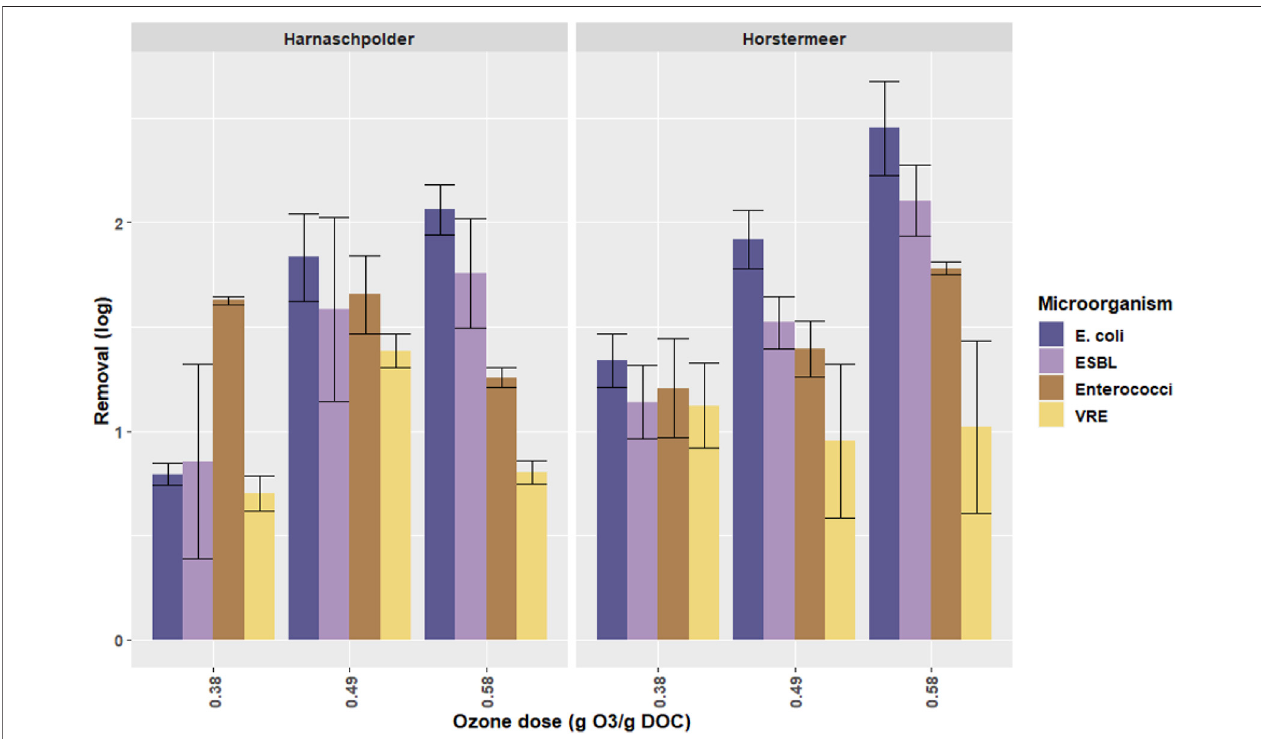
FIGURE 3 | The log removal of ARB and ASB by ozonation of secondary ef fl uent of WWTP Harnaschpolder and WWTP Horstermeer, based on four weekly grab samples per water type, measured in triplicates. The concentration of ozone is given in g O 3 /g DOC. Error bars indicate standard deviation.